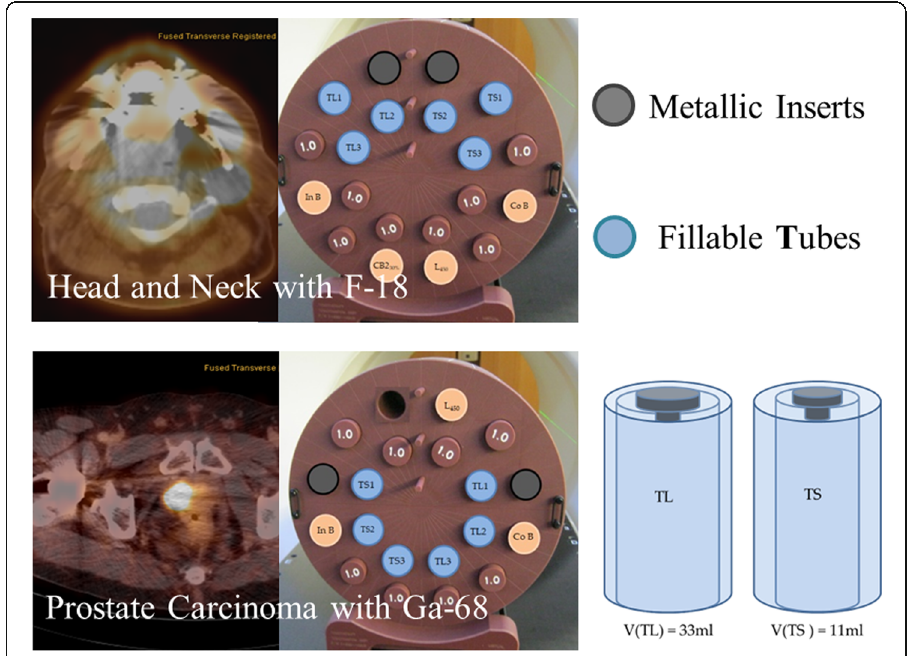
Fig. 2 Setup employed for the identification of radiomic features robust to metal artifacts in PET/CT. Metallic (gray), tissue (brown), and fillable (large tubes (TL) and small tubes (TS), blue) inserts were placed in Cheese-Phantom following the head and neck and prostate carcinoma